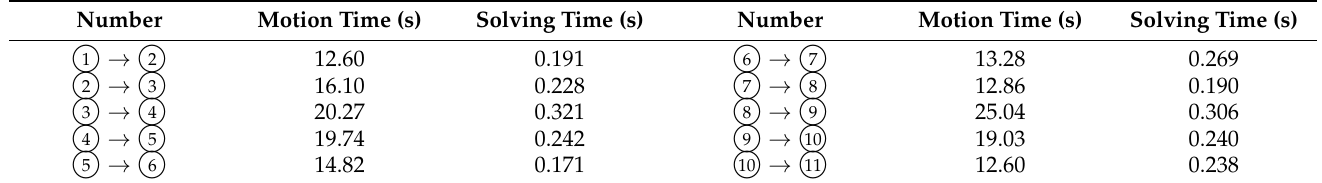
Table 2. The JS algorithm to obtain the shortest motion time and solving time for two path